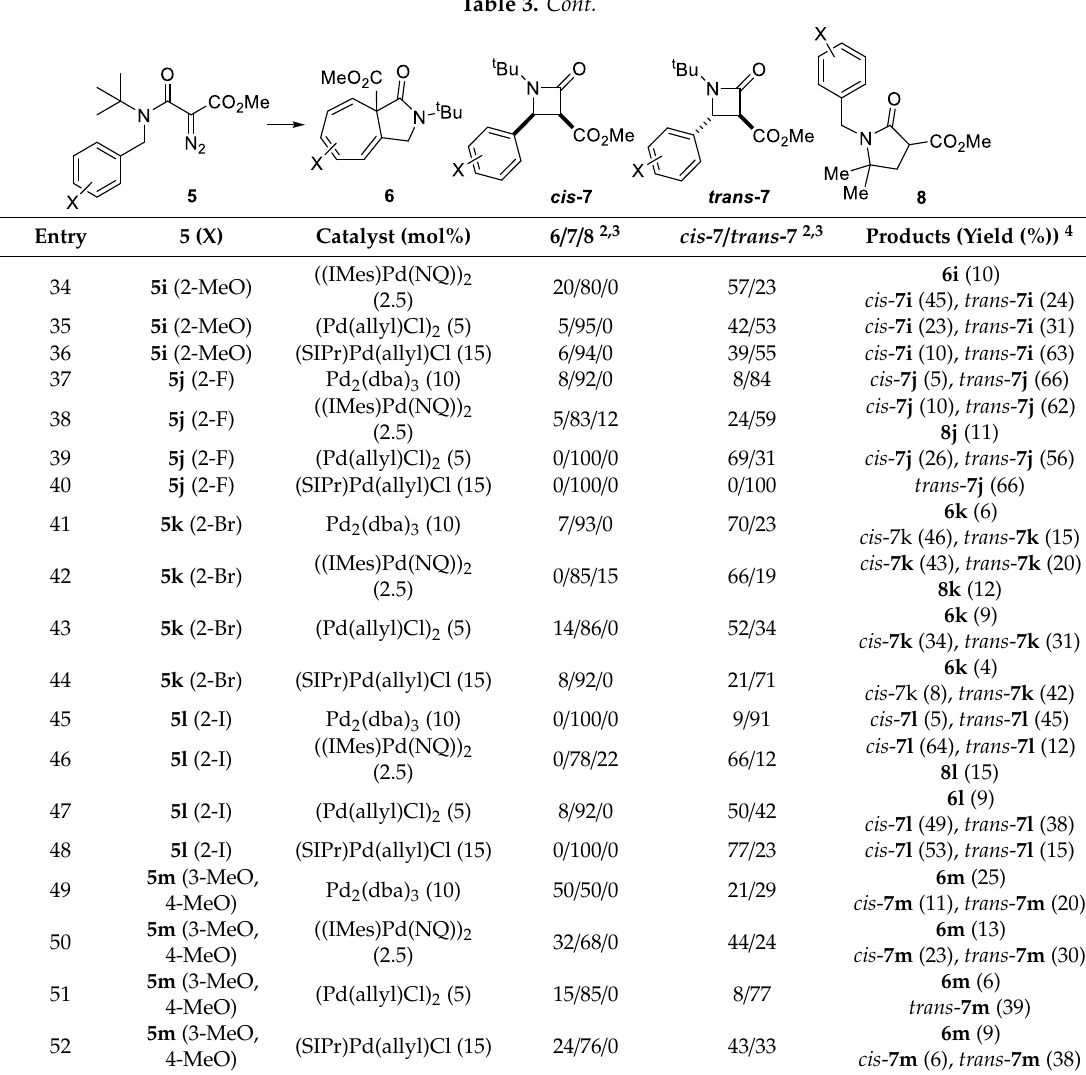
Table 3. Palladium-catalyzed cyclization reactions of α -diazoamides 5a – 5m 1 .